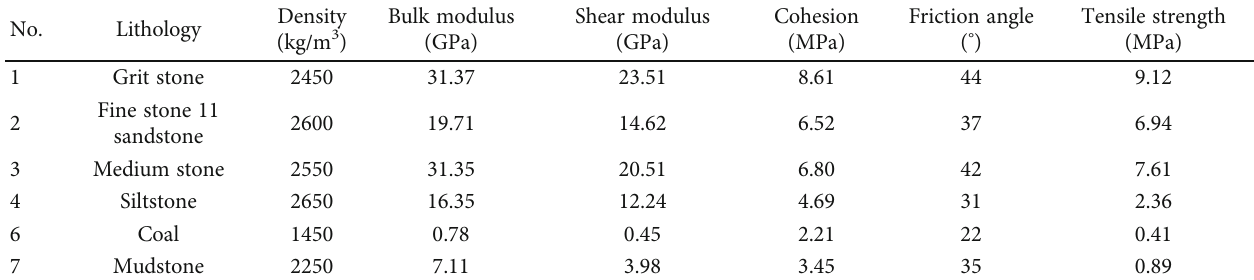
Table 1: The rock mass properties.